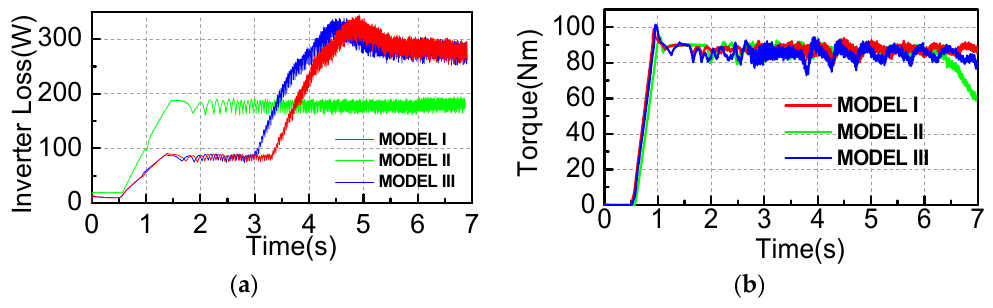
Figure 12. Simulation results of ( a ) inverter loss and ( b ) electromagnetic torque when torque setpoint is 90 Nm.